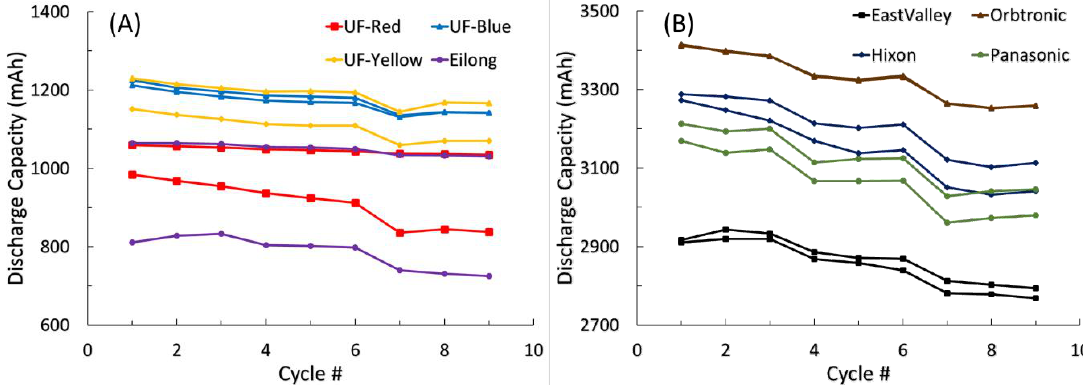
Figure 2. Cell capacity vs. cycle number for ( A ) low-cost and ( B ) high-cost cells, with cycles 1 – 3 performed at rate C/10, cycles 4 – 6 at C/5, and cycles 7 – 9 at C/2, based on cell nameplate capacity (low-cost cells all de-rated to 1200 mAh capacity rating).